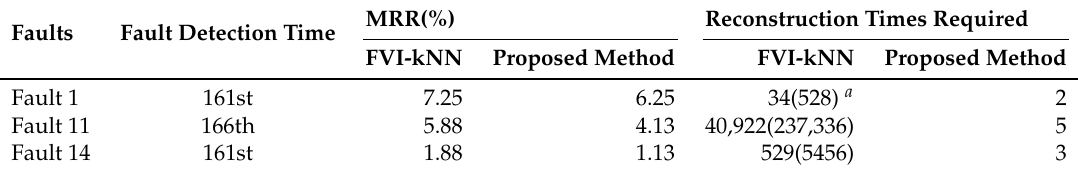
Table 2. The summarized results of the three faults on TEP.